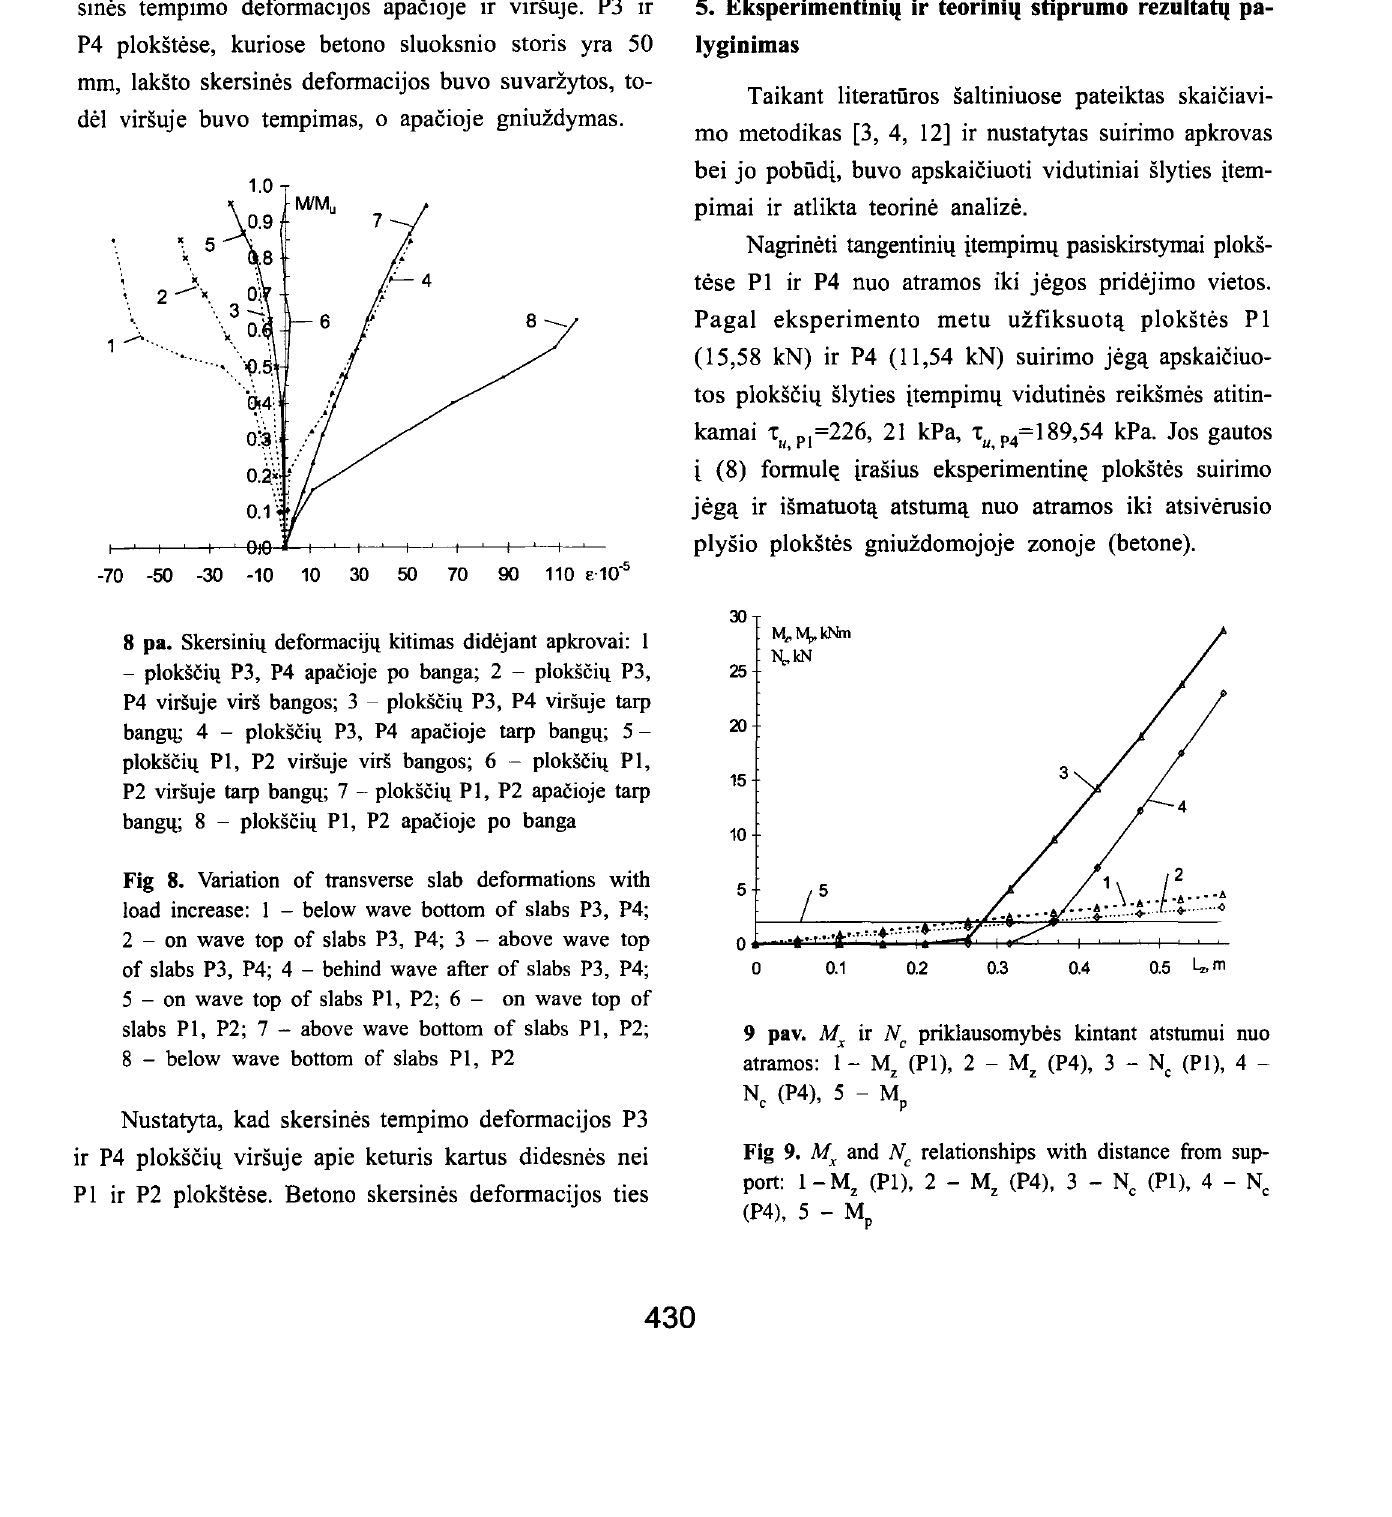
Fig 9. Mx and Nc relationships with distance from